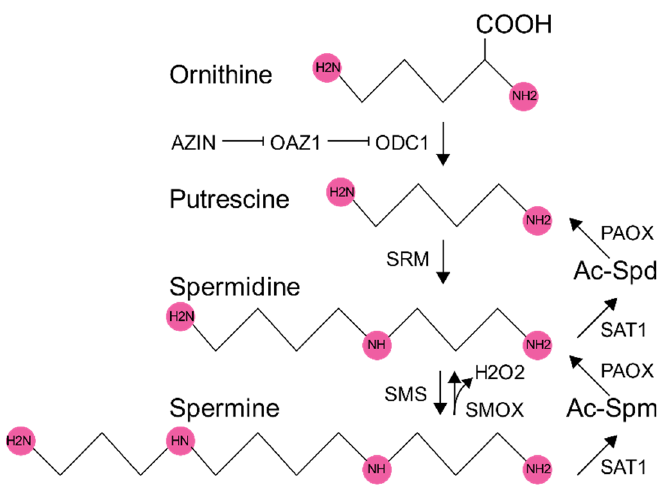
Figure 1. Schematic of the polyamine pathway in mammalian cells. An ornithine precursor is deacetylated by ornithine decarboxylase (ODC1) to form putrescine. ODC1 is inhibited through the action of ODC1 antizyme (OAZ1), which is inhibited by antizyme inhibitor (AZIN), in turn. Putrescine is converted to spermidine by spermidine synthase (SRM), and spermidine is further converted to spermine by spermine synthase (SMS). The conversion of spermine to spermidine releases hydrogen peroxide (H 2 O 2 ) by the action of spermine oxidase (SMOX). Spermine and spermidine are acetylated by spermidine–spermine acetyltransferase (SAT1) to form acetylated moieties (Ac-Spm and Ac-Spd). Acetylated spermidine or spermine can be converted to putrescine or spermidine, respectively, through the action of polyamine oxidase (PAOX).